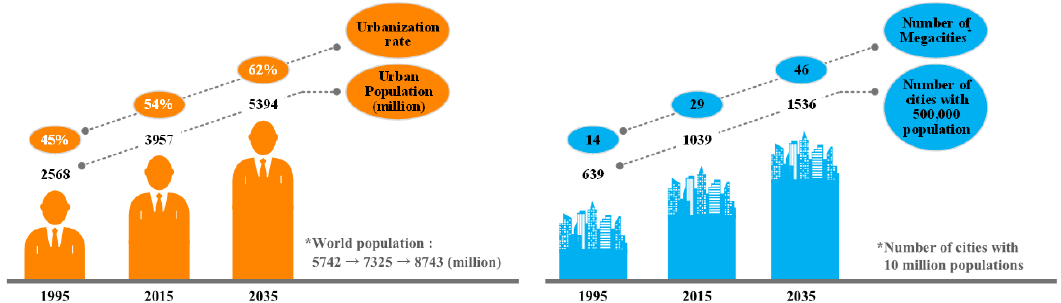
Figure 1. Growing urban population and increasing number of cities. * UN World Urbanization Prospects, POSRI (2017).